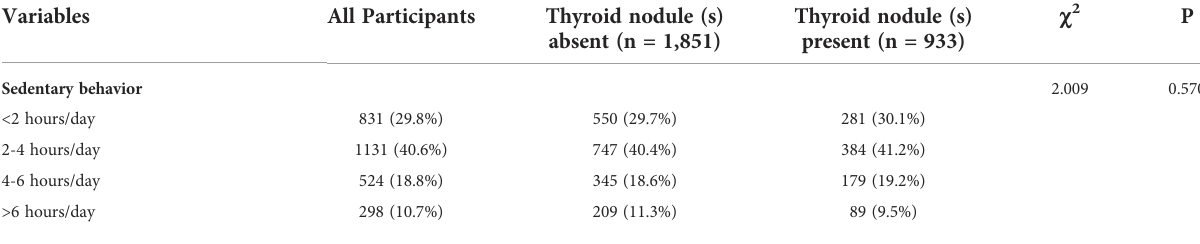
TABLE 2 Components of Metabolic syndrome among all participants with and without thyroid nodules (N = 2,784). Variables